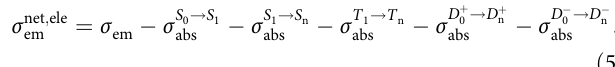
the large amount of Alq 3 triplet excitons under current injection.